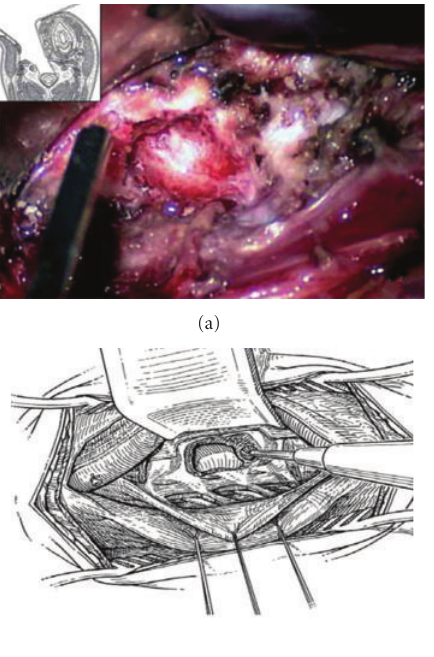
Figure 3: (a, b) Resection of lateral aspect of the vertebral body. (b) Schematic